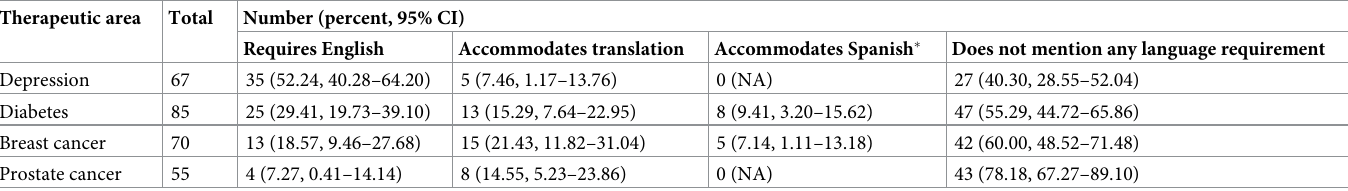
Table 3. Language requirements in clinical trials by therapeutic